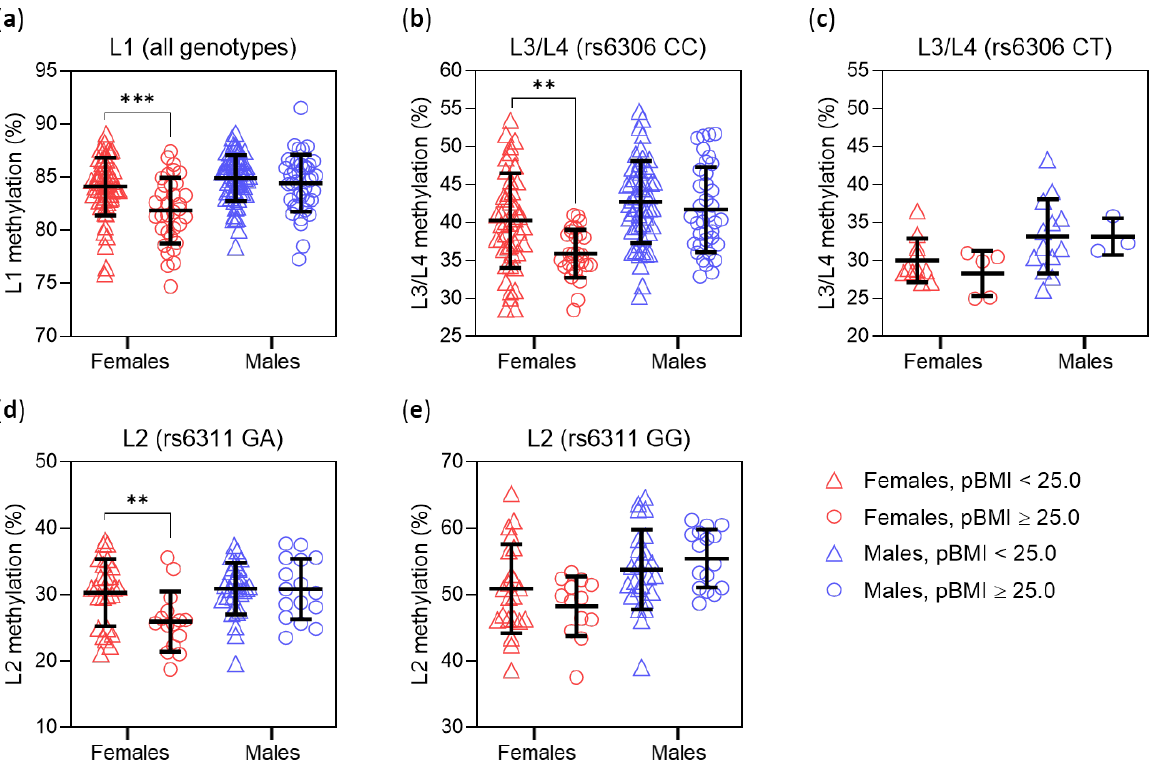
Figure 3. Placental HTR2A methylation as a function of neonatal sex and maternal pre-gestational body weight status (pBWS). pBWS was categorized based on maternal pre-gestational body mass index (pBMI). Individual values are shown, and lines indicate means and standard deviations. Sta- tistical analyses used two-way ANOVA. ( a ) L1 methylation in the total sample ( n = 194; p = 0.023 for interaction of pBWS and sex). L3/L4 methylation in ( b ) rs6306 CC homozygotes ( n = 163; p = 0.054